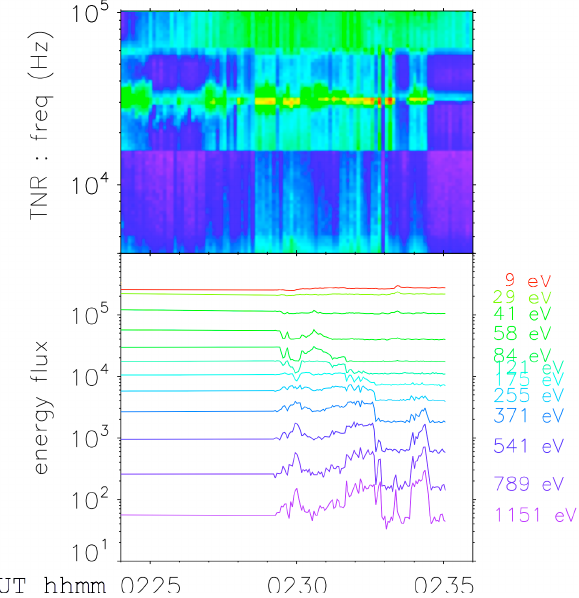
Fig. 3. Example of electric field spectrum from the WAVES in- strument (top plot) and electron flux from the Three-Dimensional Plasma and Energetic Particle Investigation (Lin et al., 1995) on 17 April